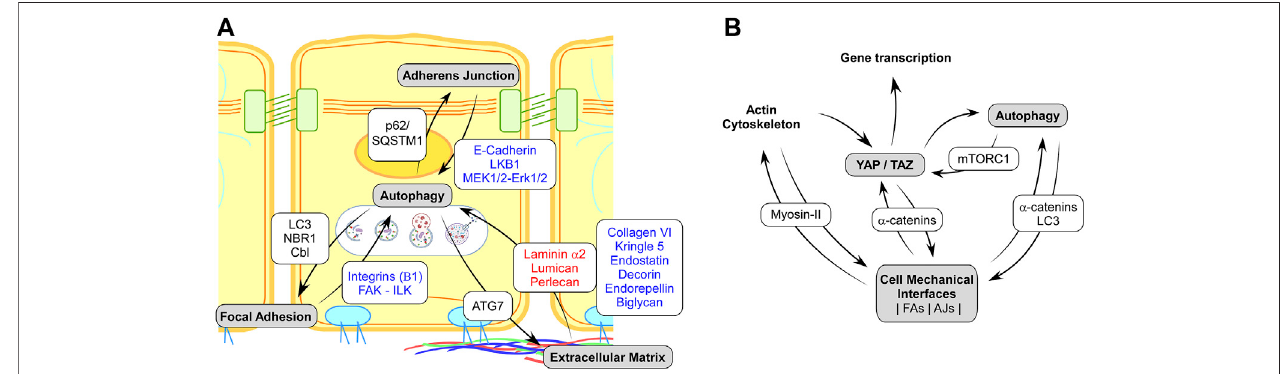
FIGURE1 |(A) Schematicrepresentation oftheknown interplays between themechanosensitivecell adhesions complexesand autophagy.Red and blue texts on white background indicate protein showing a negative or positive regulation of autophagy, respectively. Text in black on white background indicates proteins of the autophagy machinery targeting speci fi c disassembly and recycling of Adherens Junction, Focal Adhesion, or Extracellular Matrix. (B) . Schematic representation of regulatory interaction involving cell mechanics, Autophagy and YAP/TAZ mechano-signaling. Black on white background text indicates the main proteins involved in the regulatory